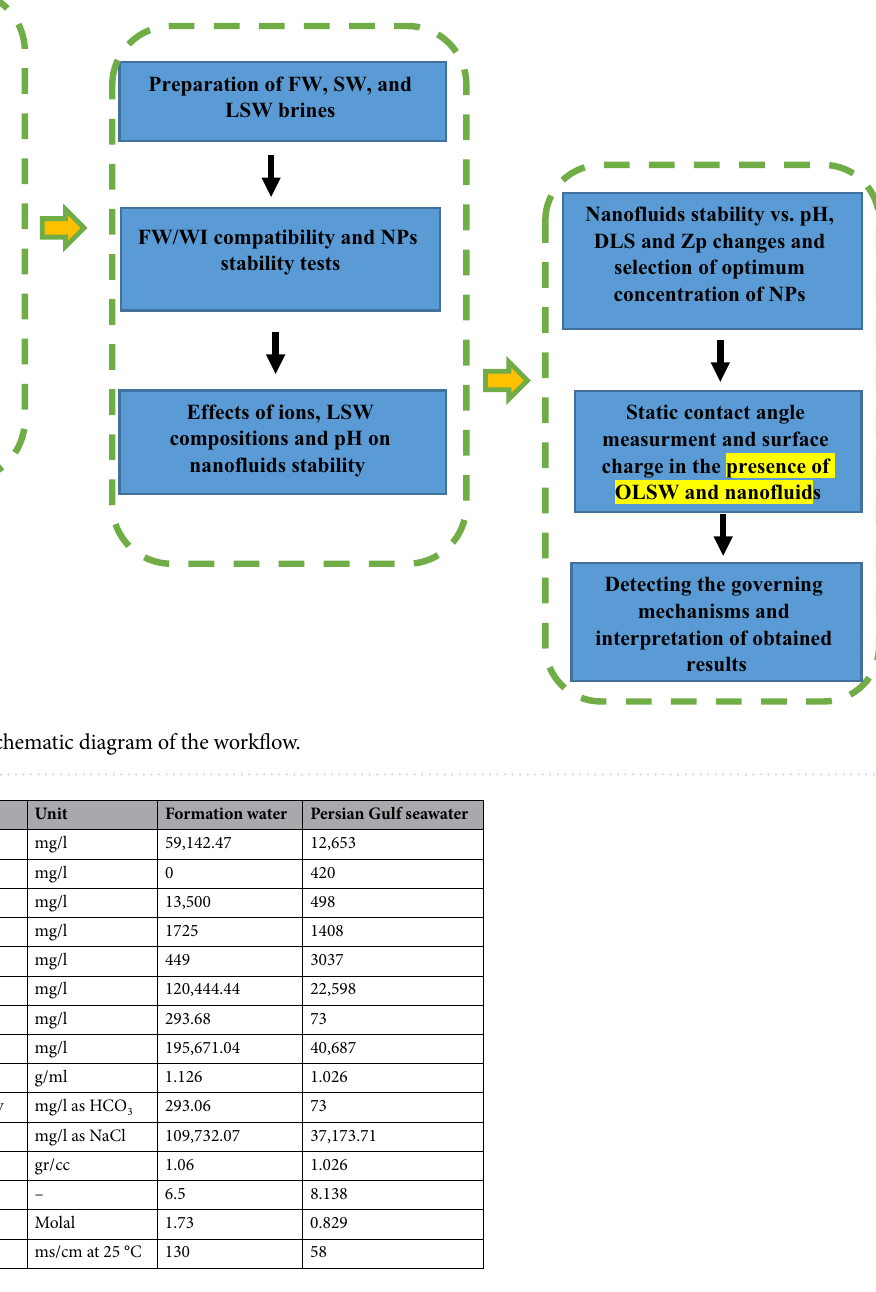
Table 1. Complete water compositions of the FW and seawater